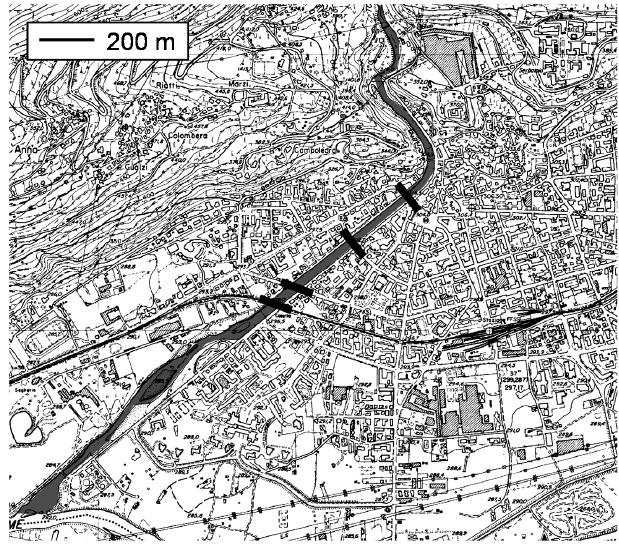
Figure 4. The Mallero River (shaded) crossing the town of Sondrio (map extracted from the Regional Technical Chart of Lombardia). The course of the Mallero is depicted in the last 2 km until the inflow into the Adda. The black thick lines represent four in ‐ town bridges, named Garibaldi, Eiffel, Marcora, and Railway from upstream to downstream.